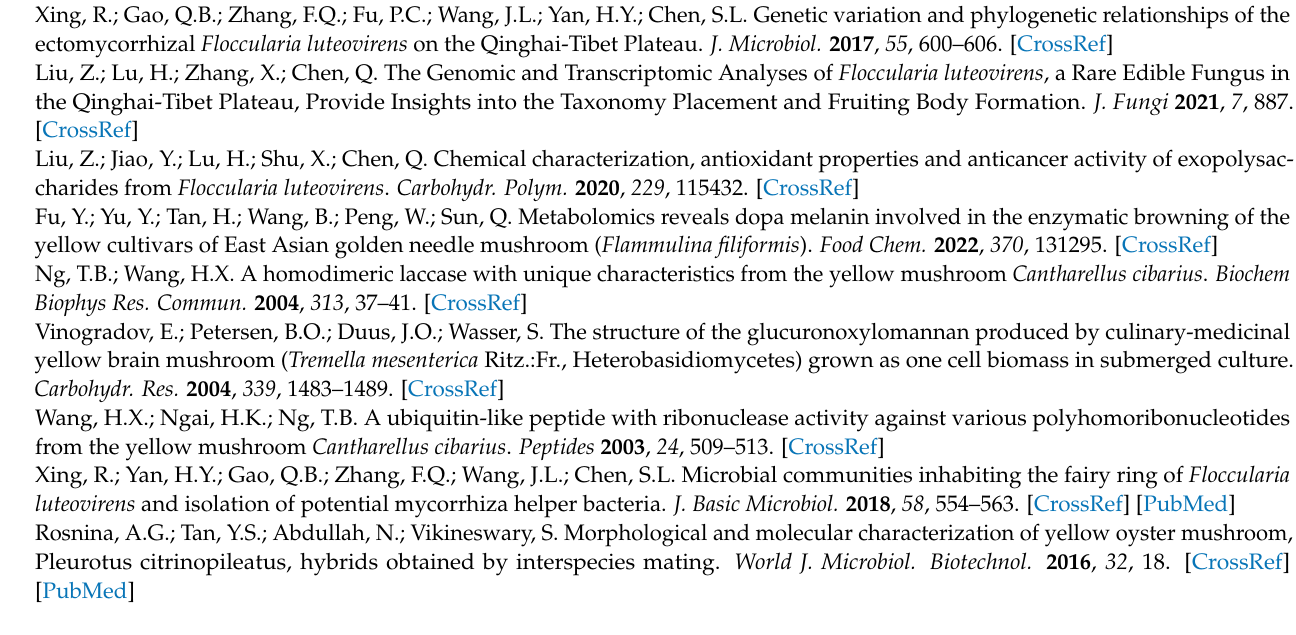
spectrometry. Figure S2. PCA cluster analysis of the metabolome. Figure S3. OPLS-DS cluster analysis of compounds. Figure S4. All genes’ KEGG pathway enrichment. Figure S5. KEGG pathway enrichment of differentially expressed genes. Figure S6. Combined enrichment analysis of all differentially expressed genes and compounds. Table S1. All chemical compounds in yellow and white mushrooms. Table S2. The different accumulation of chemical compounds in yellow and white mushrooms. Table S3. Distribution of the clean reads of the sequencing. Table S4. Distribution of the lengths of the assembled unigenes. Table S5. Phylogenetic analysis of KOG species. Table S6. The primers used in this study. Table S7. The expression differences of structural and regulatory genes in the riboflavin biosynthesis pathway. Table S8. The different expressions of unigenes in yellow and white mushrooms. Table S9. The KEGG pathways of different expressions of unigenes and different accumulations of chemical